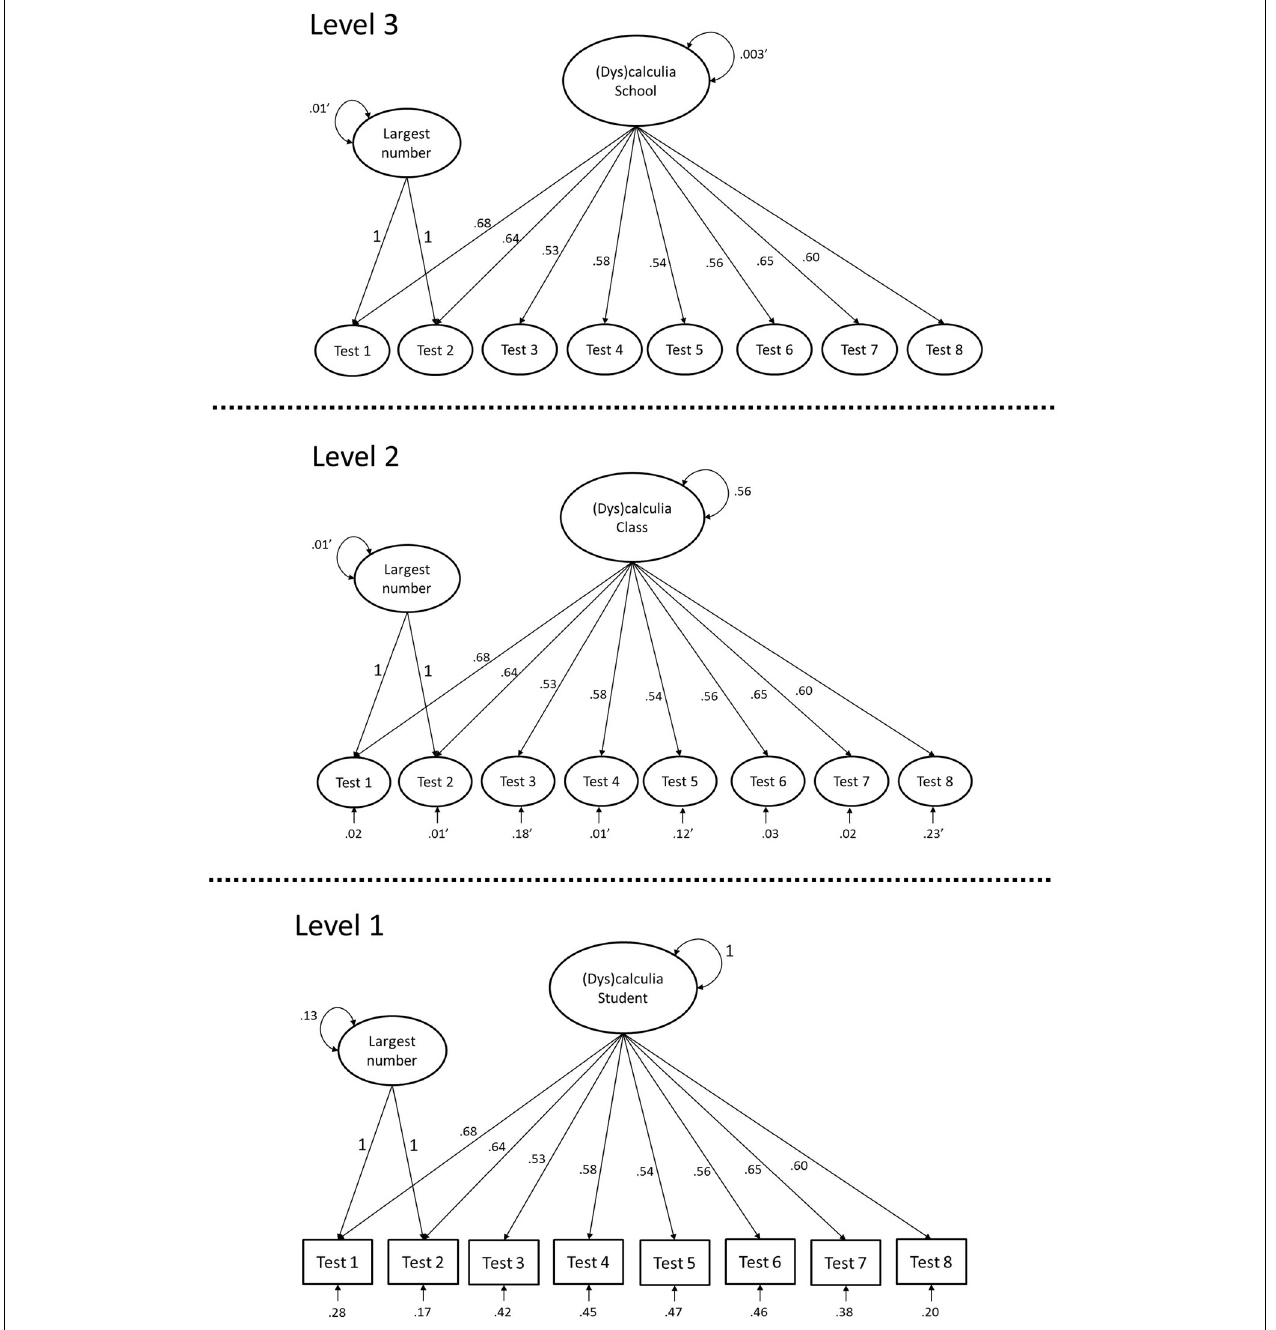
FIGURE 1 | A three-level factor model with equal factor loadings across levels and no residual variance at Level 3. Parameter estimates are unstandardized. Non-significance is indicated by an apostrophe ( (cid:2)